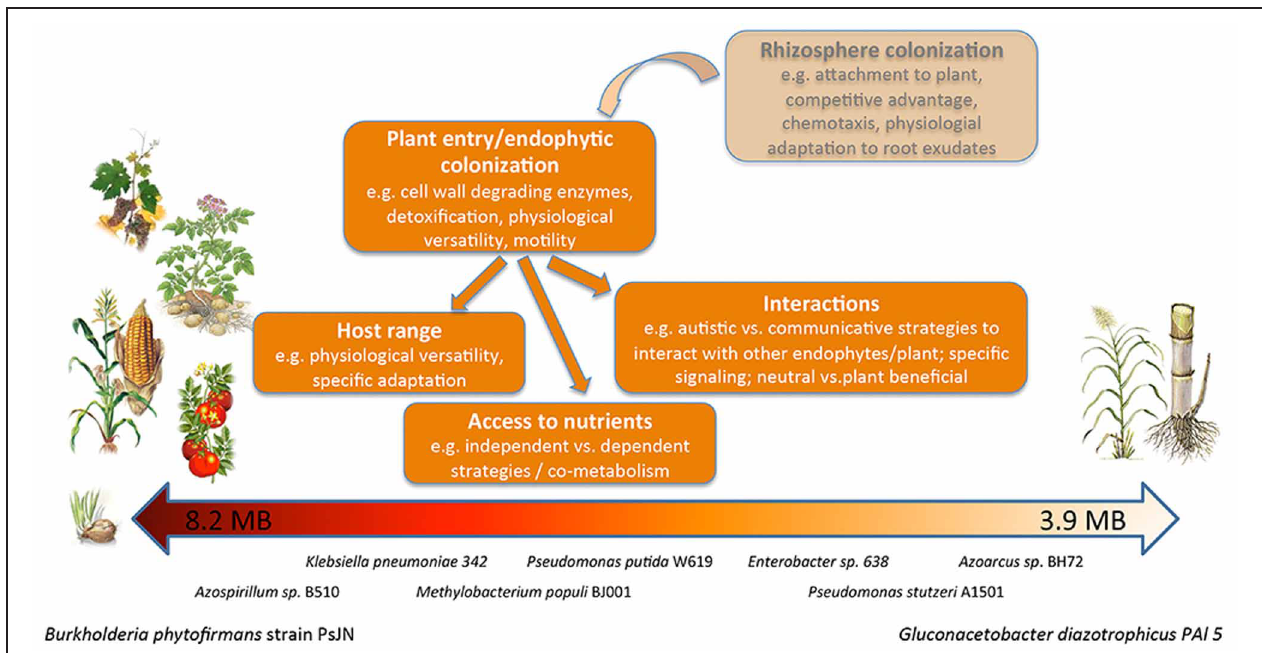
FIGURE 2 | The spectrum of endophytes analyzed in this study. Drawing illustrating the differences in genome size and reported host spectrum of the endophytic bacteria analyzed in this study and summarizing the features of the endophytic